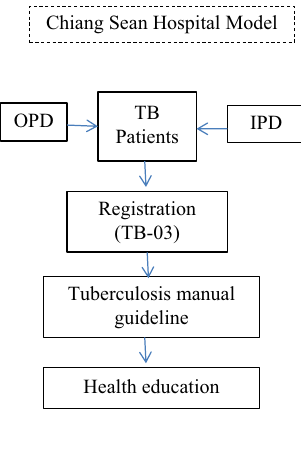
Figure 1. Process of TB treatment and care in Mae Sai Hospital (Model 1) and Chiang Sean Hospital (Model